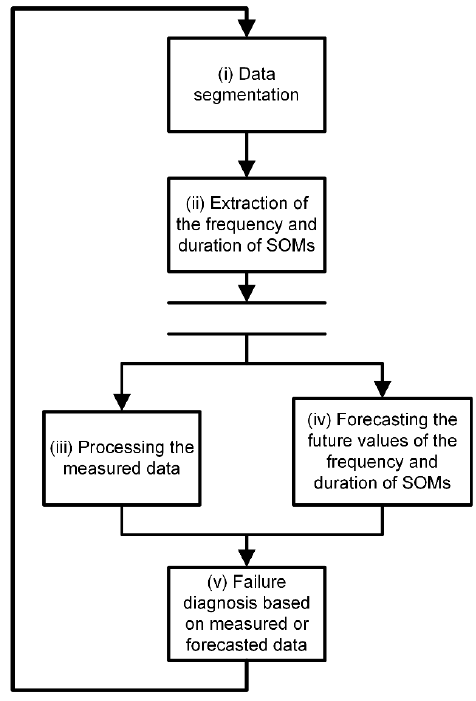
Figure 1. Procedure of the proposed computational failure forecasting method.